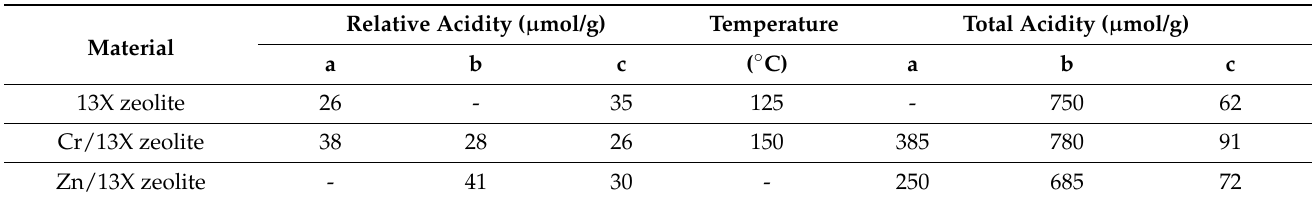
Table 5. The acidity of 13X zeolite, Cr/13X zeolite and Zn/13X zeolite catalysts.